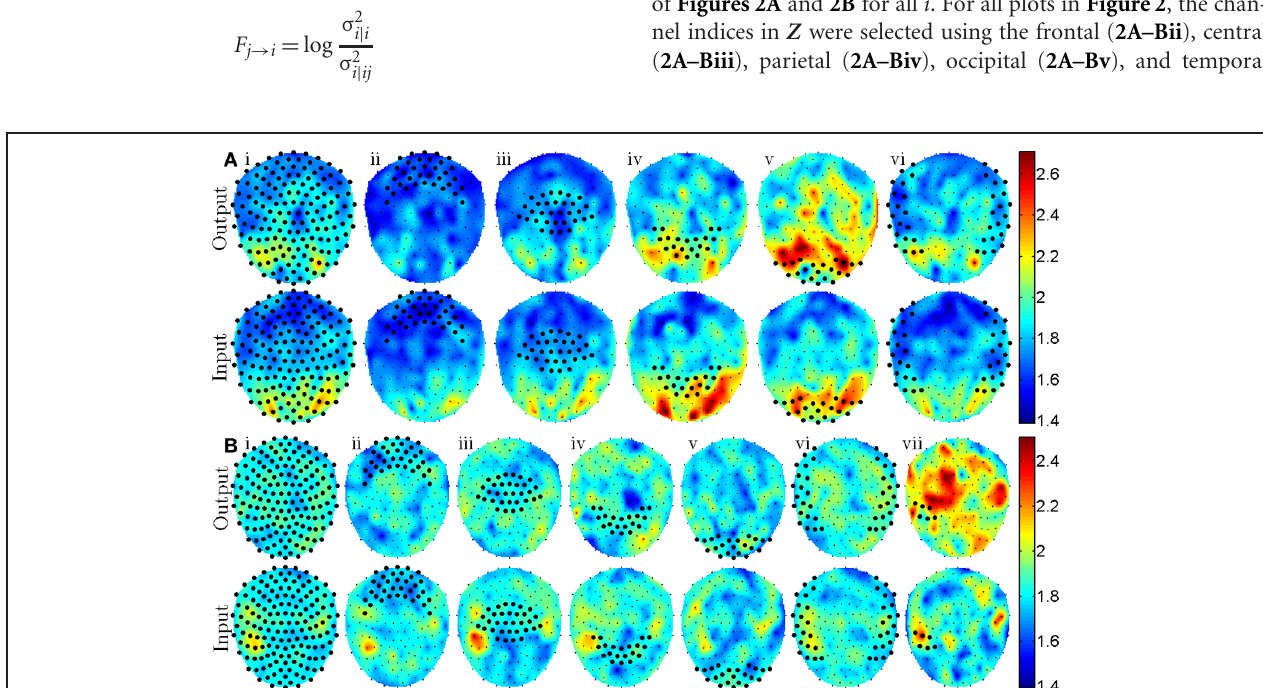
FIGURE 2 | Topographic plots show the sensor positions where the most notable differences in GC features exist [mean t -statistics defined by Equations (2) and (3)] for the visually cued experiment (A) and the aurally cued experiment (B). Top rows of (A and B) indicate regions of major difference in free and forced GC features that have outputs from sensors